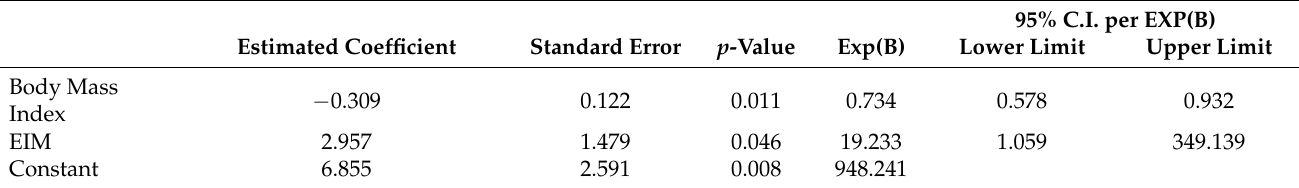
Table 3. Multivariate analysis: logistic regression coefficients and 95% confidence intervals.